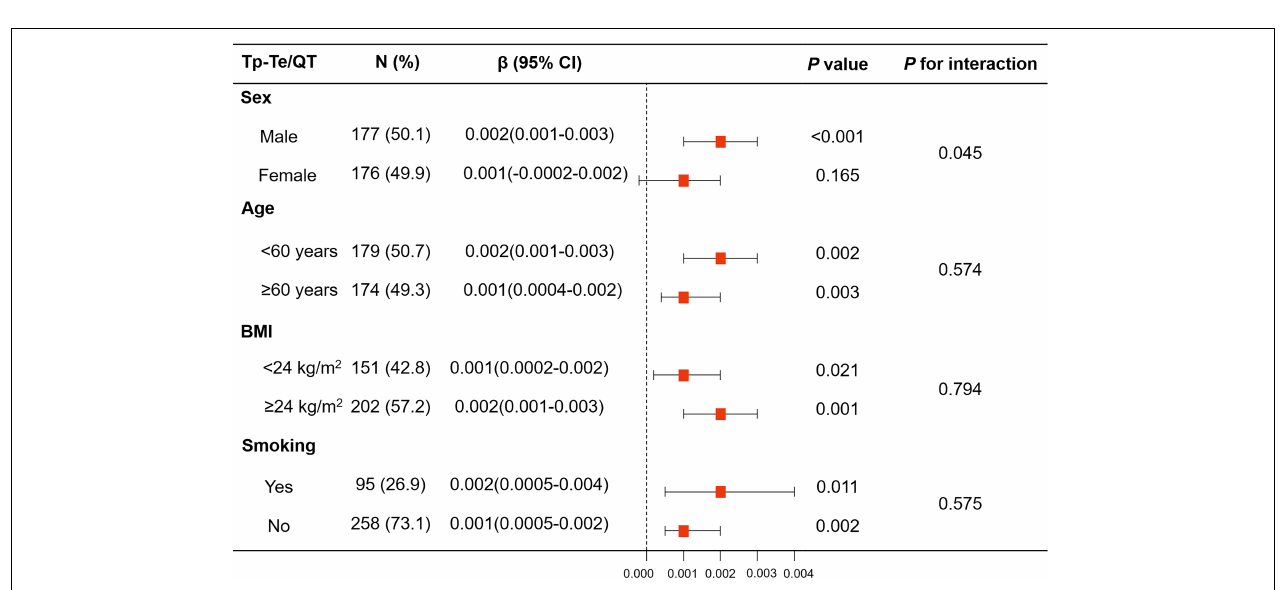
FIGURE 3 | Logistic analysis of anxiety for LVH in subgroup analyses stratified by sex, age, body mass index (BMI), and smoking. The associations of anxiety with LVH showed interaction with sex, while there was no interaction with age ( < 60 years vs. ≥ 60 years), BMI ( < 24 kg/m 2 vs. ≥ 24 kg/m 2 ), and smoking. BMI, body mass index; LVH, left ventricular hypertrophy.